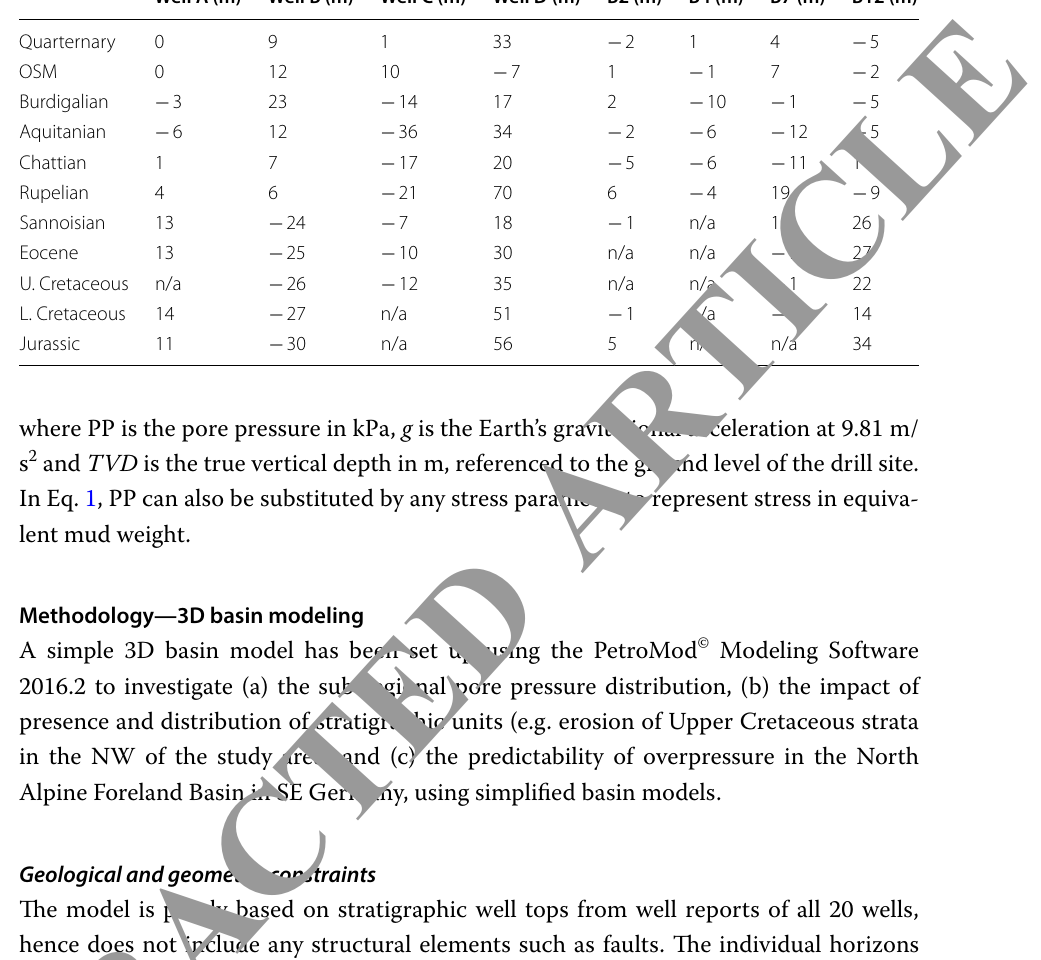
Table 2 Depth difference between actual well tops of wells within the AOI and modeled stratigraphic tops Well A